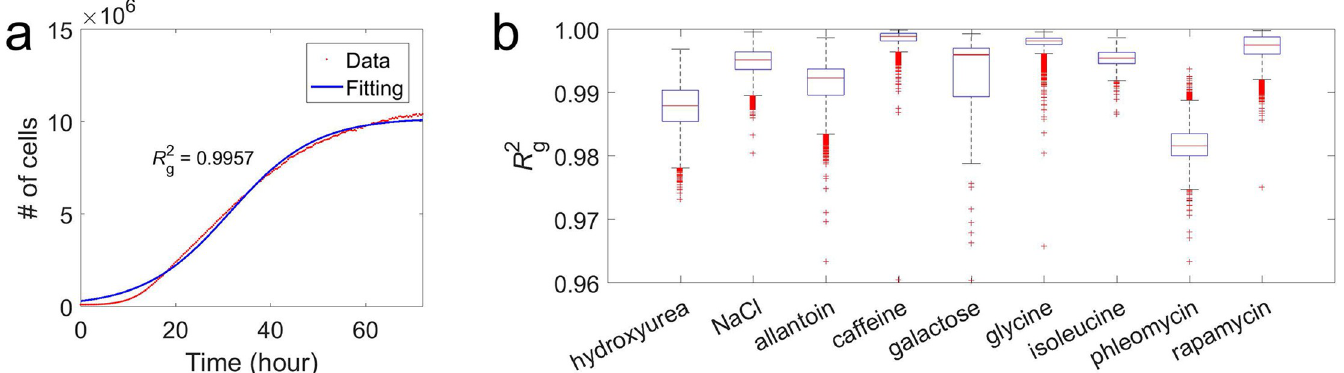
Fig 1. Yeast growths fit logistic curves. ( a ) An example of yeast growth in the galactose medium and the fitted logistic curve. Red dots represent observed data from one replicate of a genotype, and the blue line is the fitted curve. R g2 from the logistic curve is presented. ( b ) Distribution of R g2 among all genotypes in each of the nine environments. The lower and upper edges of a box represent qu 1 and qu 3 , respectively; the horizontal red line inside the box indicates md; the whiskers extend to the most extreme values inside inner fences, md ± 1.5 (qu 3 –qu 1 ); and the red crosses represent values outside the inner fences (outliers). Data are available at https://github. com/AprilWei001/Environment-dependent-r-K-relations. md, median; qu, quartile.